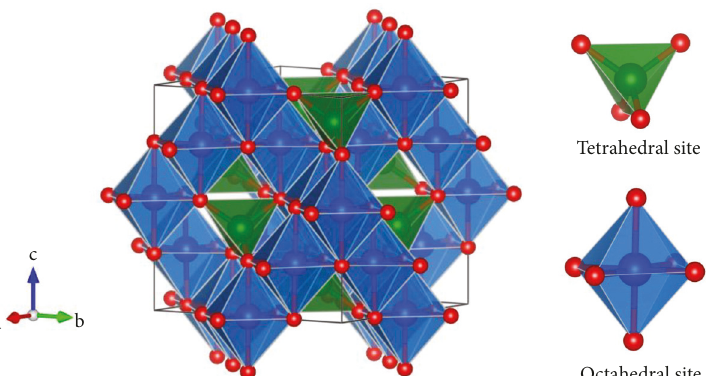
Figure 1: The cubic spinel structure. The oxygen locations are shown in red, while the tetrahedral and octahedral cation sites are indicated in green and blue,